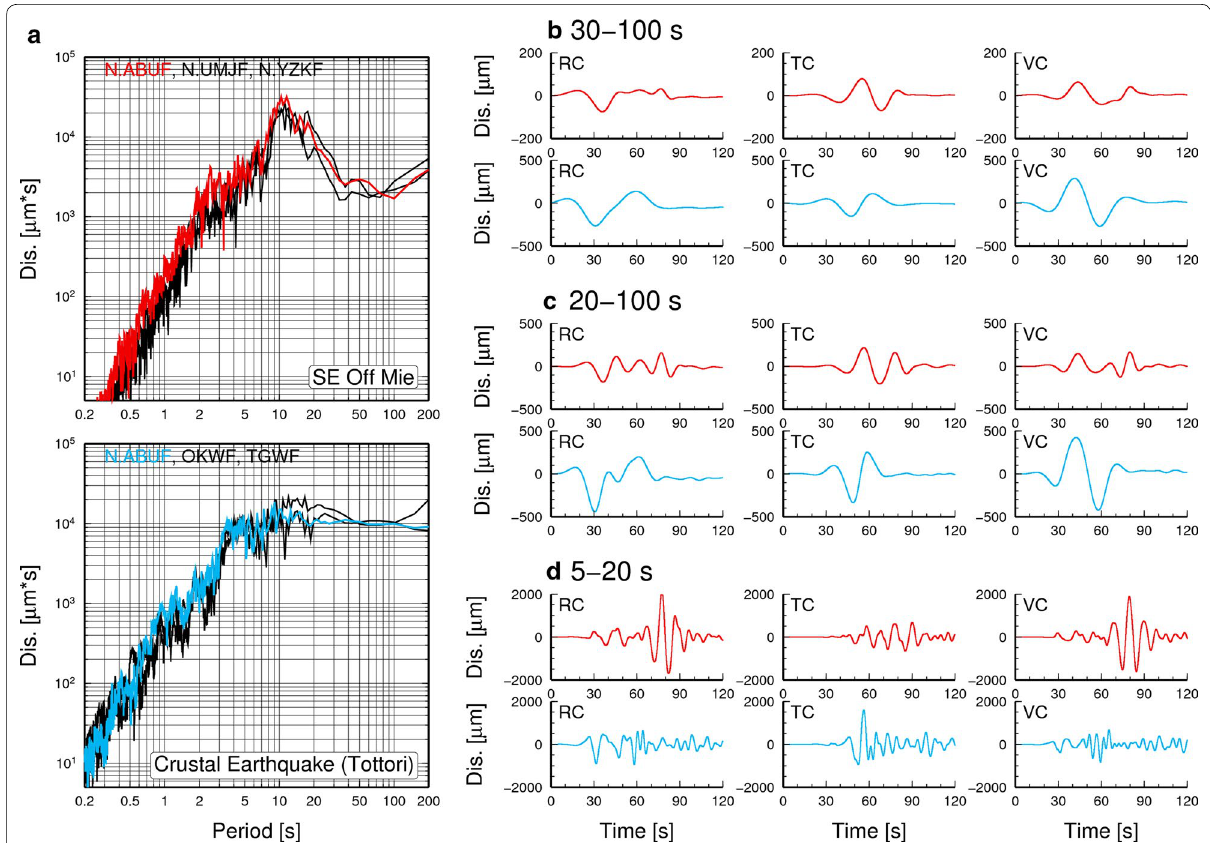
Fig. 2 Broadband F-net displacement records during the 2016 southeast offshore Mie earthquake. a Displacement spectra of the SE offshore Mie earthquake ( M 6.5) and central Tottori earthquake ( M 6.6), which occurred within the crust. Locations of stations and the epicenter are shown in Fig. 1. Displacement waveforms at F-net station N.ABUF for periods of b 30–100 s, c 20–100 s, and d 5–20 s. Red and blue lines are observed records at N.ABUF during the SE offshore Mie and central Tottori earthquakes, respectively. RC, TC, and VC in ( b )–( d ) represent the radial, transverse, and vertical components,